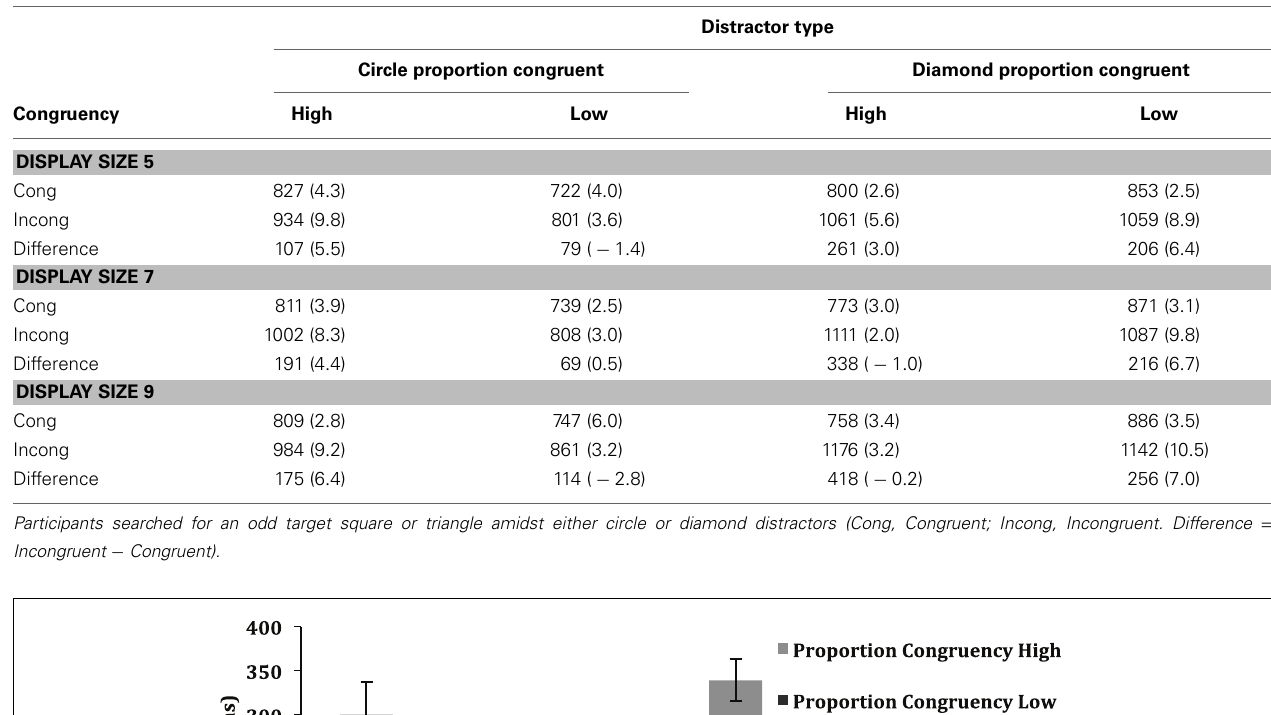
Table 4B | Mean response times and error percentages (in parentheses) for the uninformative cued (uncued) trials, collapsed across target (triangle/square) and block, in Experiment